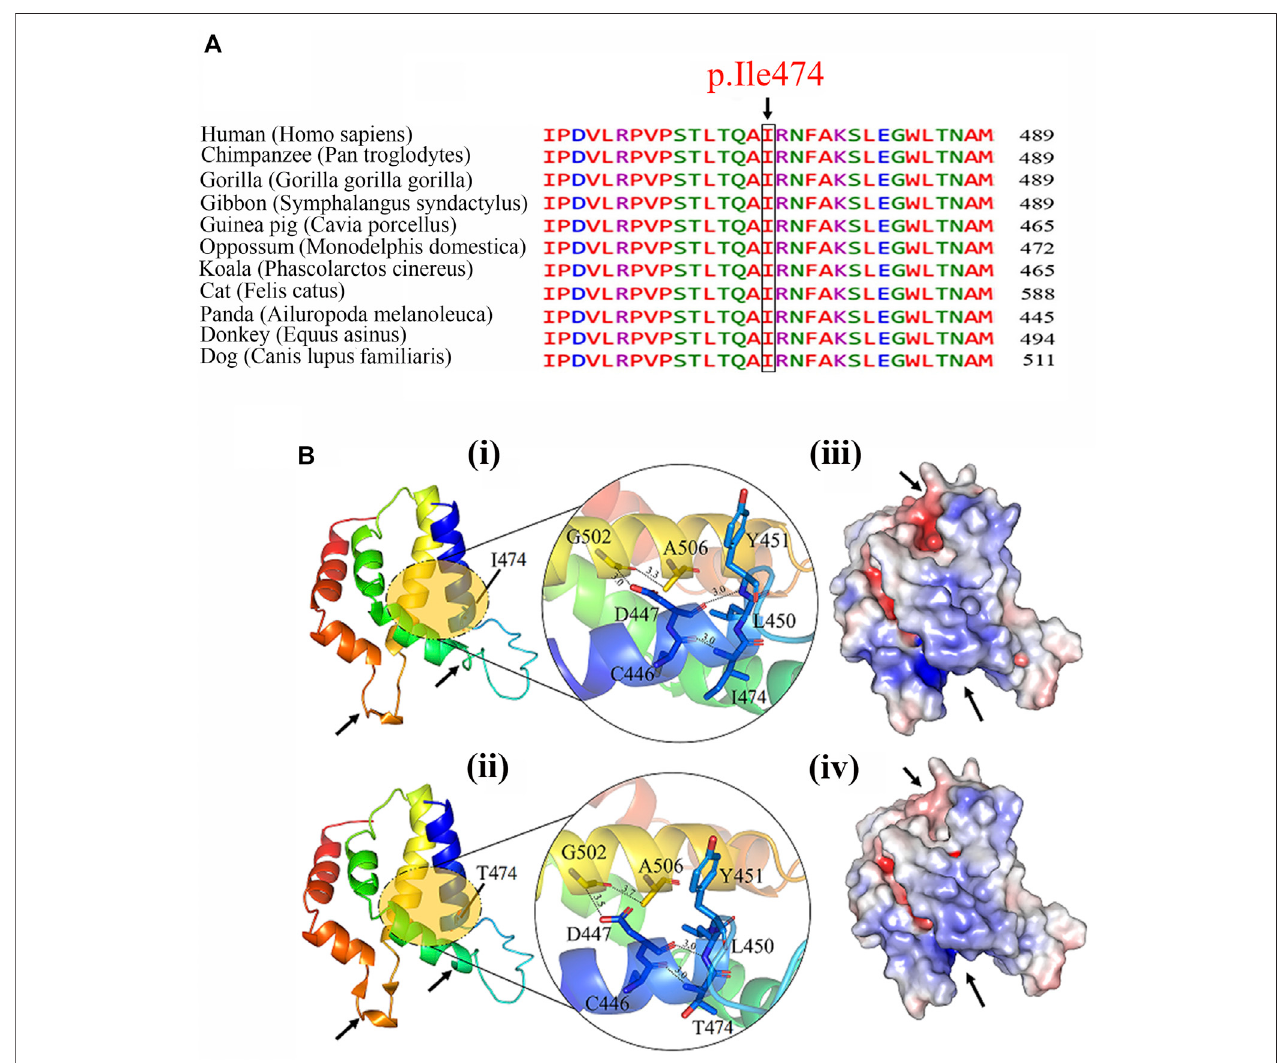
FIGURE 3 | (A) Multiple sequence alignment of Ile474 with its mammalian orthologs, showing conserved wild-type residue (Isoleucine) at this position. (B) The predicted structure of wild (i) and mutant (ii) of RFX2 protein. Zoom-up view of interaction pattern of the nearby residues of wild-type and mutant protein. Possible structuraleffectsofsubstitutingconservedisoleucineintoathreonineatresidue474arehighlightedwithanarrowandsurfacechargedistributionof (iii) wild-typeand (iv) mutant-